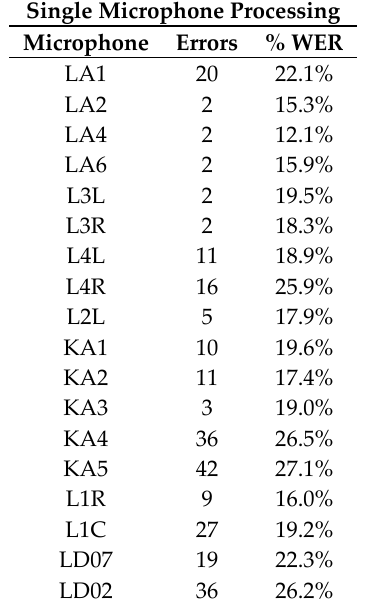
Table 1. Results of processing the audio signal individually (the microphone ids correspond to the ones in Figure 4).